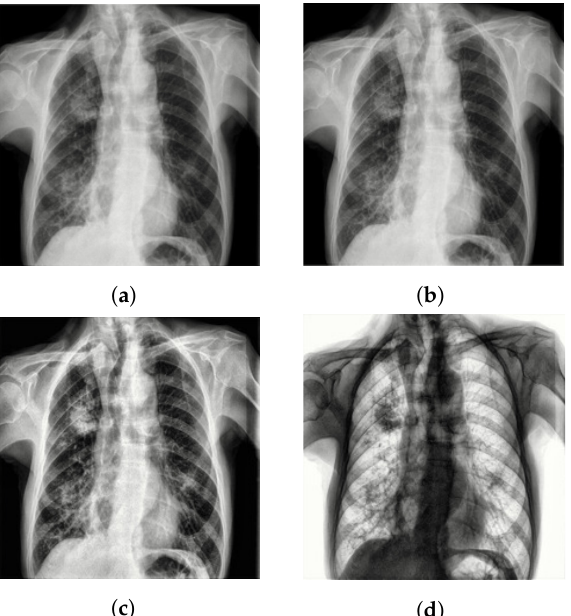
Figure 3. Image Pre-processing applied to X-ray. Original X-ray from [8]. ( a ) Original Image. ( b ) Image Reshaped to 227 × 277. ( c ) Histogram Equalization Applied. ( d ) Image